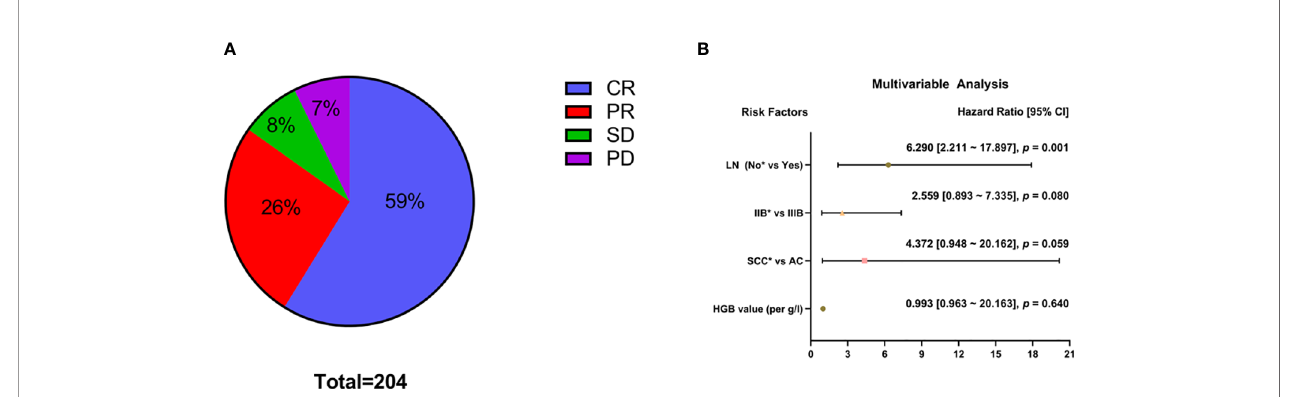
FIGURE 1 | Analysis of short-term ef fi cacy (N = 204). Speci fi c patterns of (A) short-term ef fi cacy. (B) Multivariable analysis; *Reference